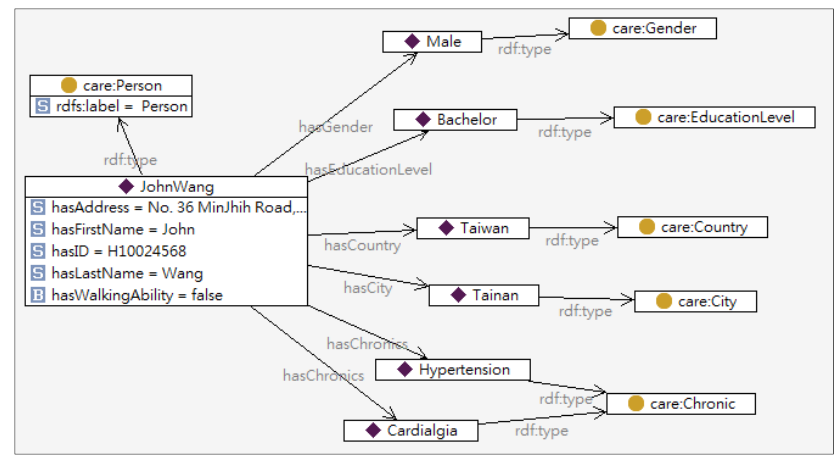
Figure 11. Partial ontology model of John’s